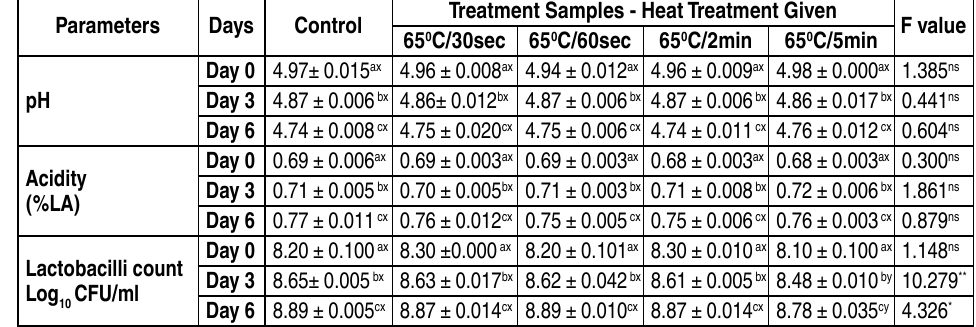
Table 2. pH, titratable acidity and count of Lacticaseibacillus rhamnosus 18 fermented dahi samples subjected to